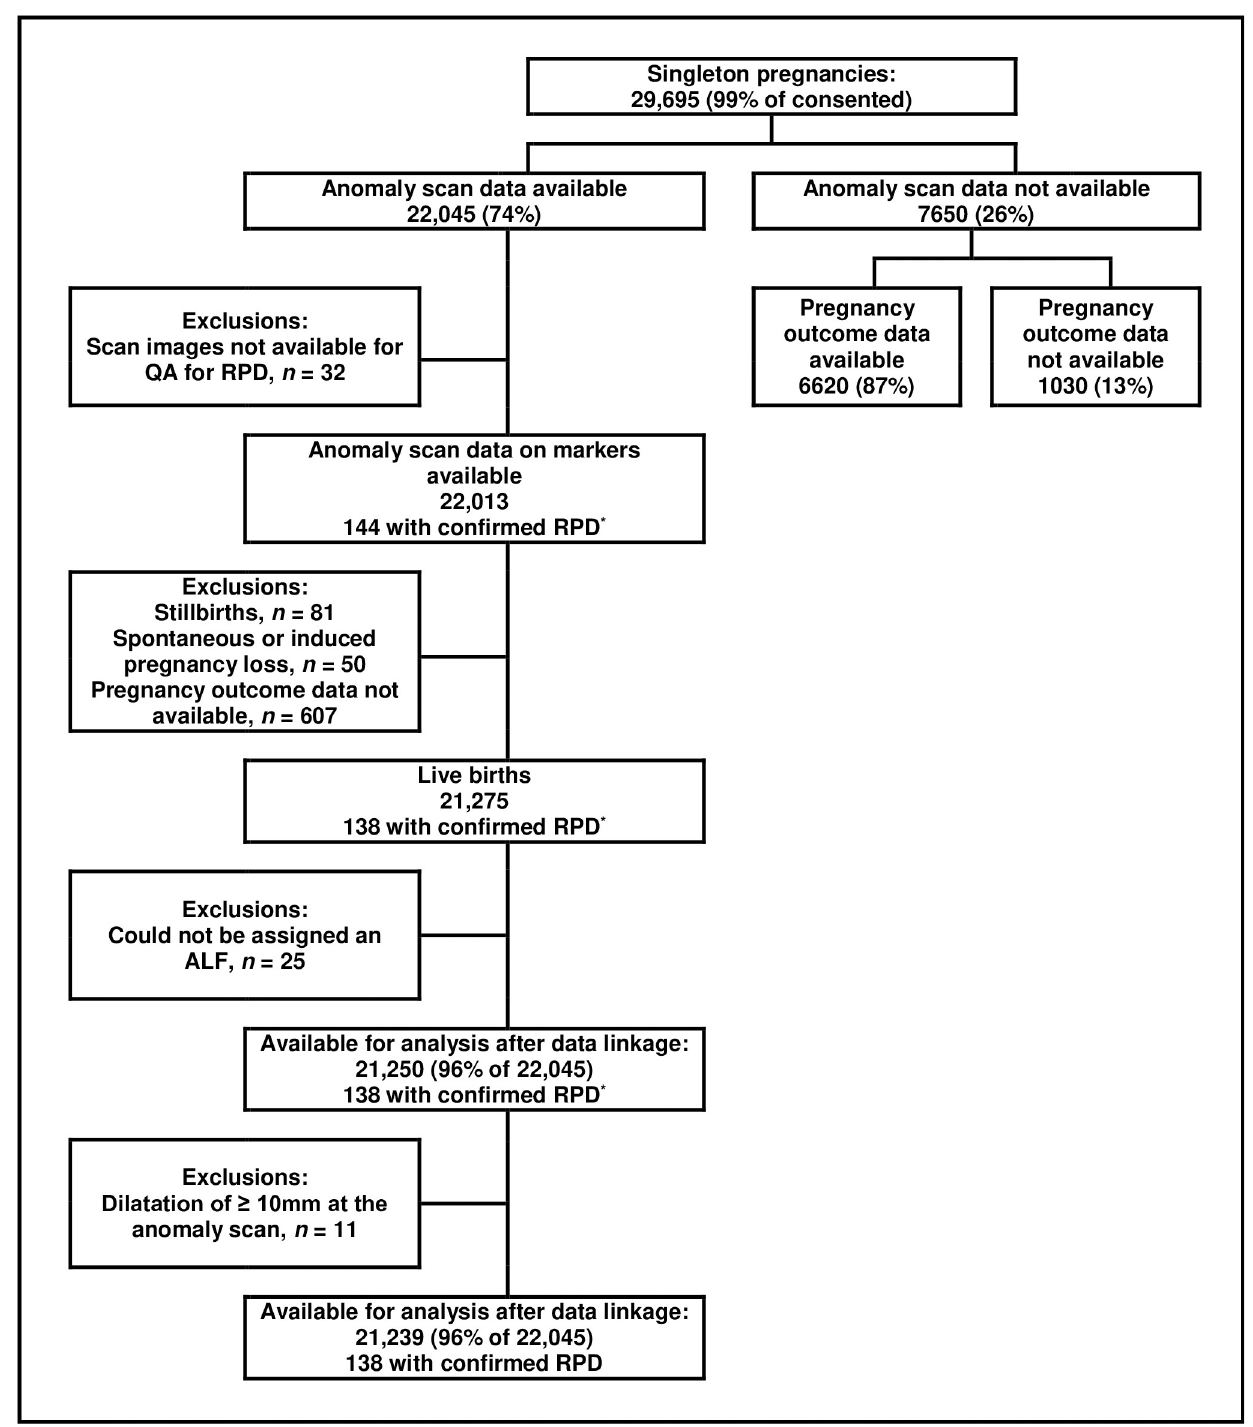
Fig 1. Cohort flow diagram. ALF, anonymised linking field; QA, quality assurance; RPD, renal pelvis dilatation.